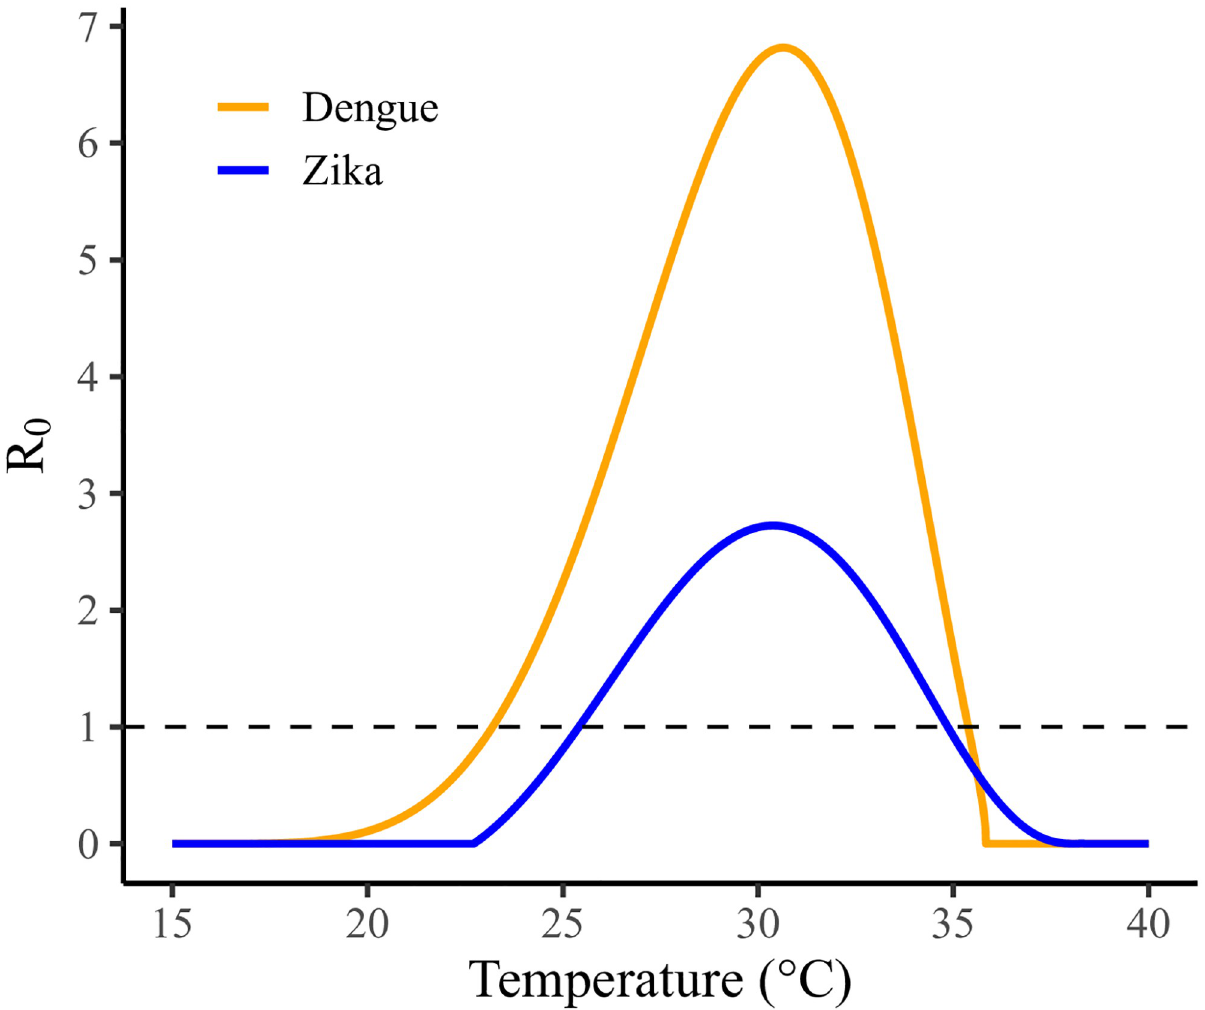
Fig 2. Temperature-dependent R